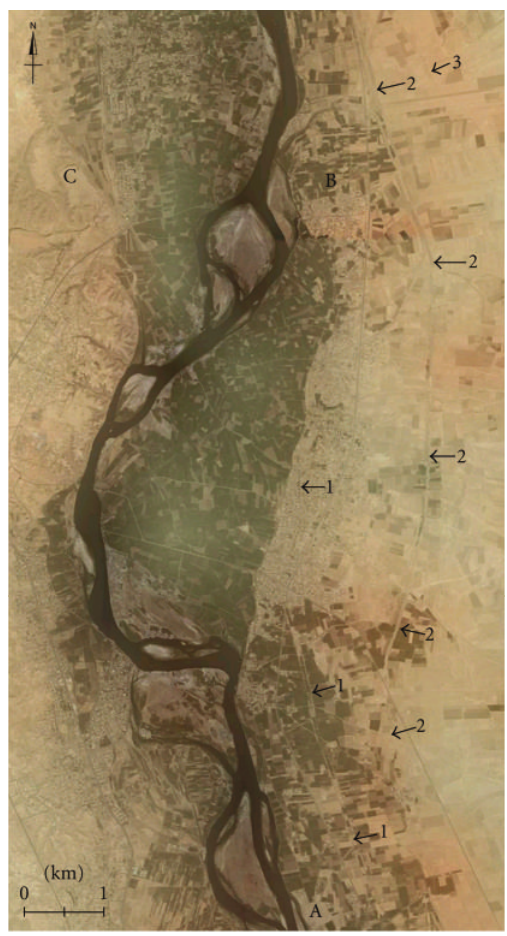
Figure 6: Remains of Assyrian and Islamic canals along the eastern bank of the Tigris, between Kar-Tukulti-Ninurta (A) and Tell Haikal (B), in a pan-sharpened (bands 3-2-1) QuickBird-2 image of 2002: 1, Pattu-m¯eˇsari ; 2, Nahr Qanausa; 3, o ff -takes or secondary branches of the Nahr Qanausa. On the west bank of the river is Tell Khuwaish (C).